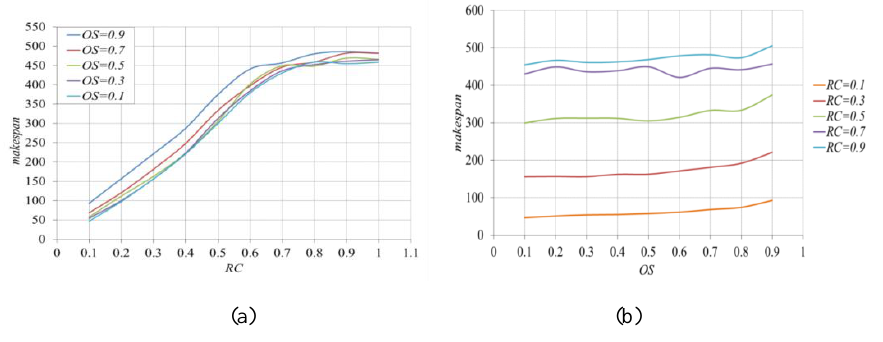
Fig.14 The impacts of RC and OS on the makespan